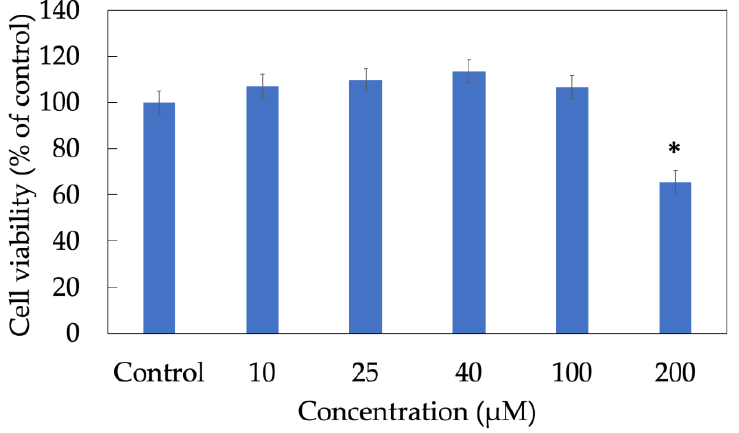
Figure 2. Cell viability of HaCaT keratinocytes treated with morin. Data were from triplicate experiments and presented as mean ± SD. * indicates a statistically significant difference with control, p < 0.05.